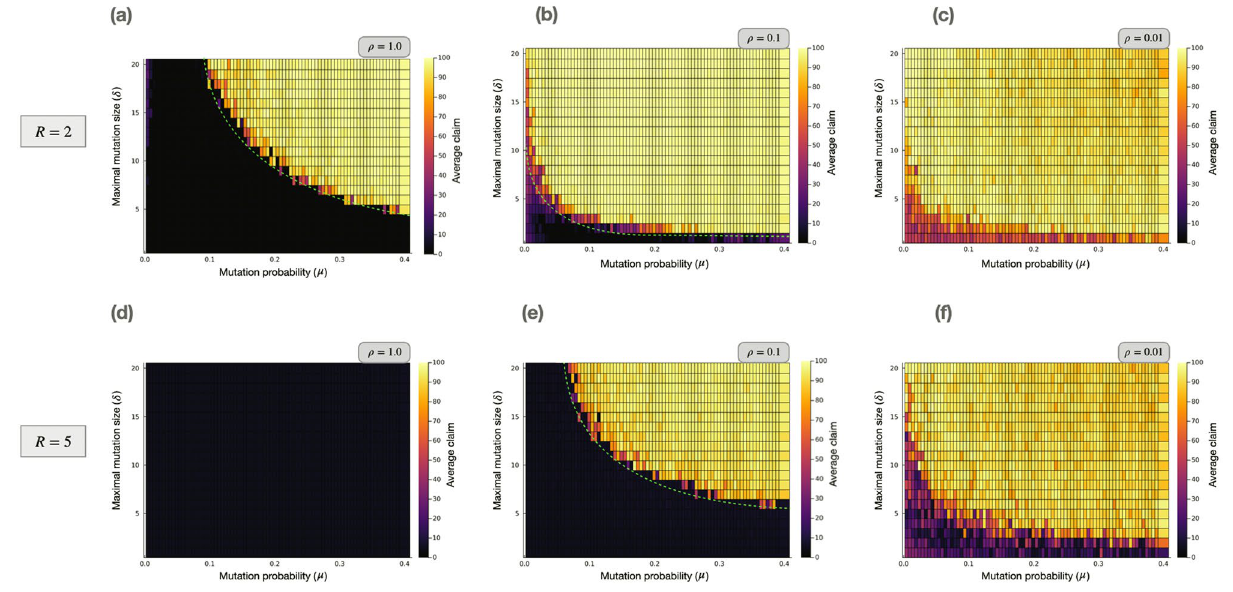
Figure 3. Wright–Fisher model with selection and mutation for the Traveler’s Dilemma. The graphs show 100 after t 1000 time steps, for different reward and selection the average claim of a population of size N = = 2, ρ 1.0 ( b ) R 2, ρ 0.1 ( c ) R 2, ρ 0.01 , and ( d ) R 5, ρ 1.0 ( e ) intensity values: ( a ) R = = = = = = = = 5, ρ 0.1 ( f ) R 5, ρ 0.01 . In general, a large mutation probability ( µ ) and a large maximal mutation R = = = = size ( δ ) allow for convergence to high claims, given that these quantities are proportional to the diversity